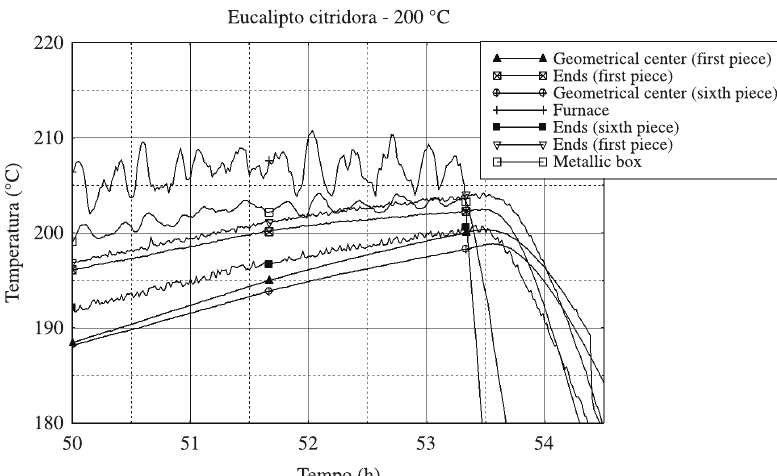
Figure 1. Thermal treatment at temperature of 200 °C.